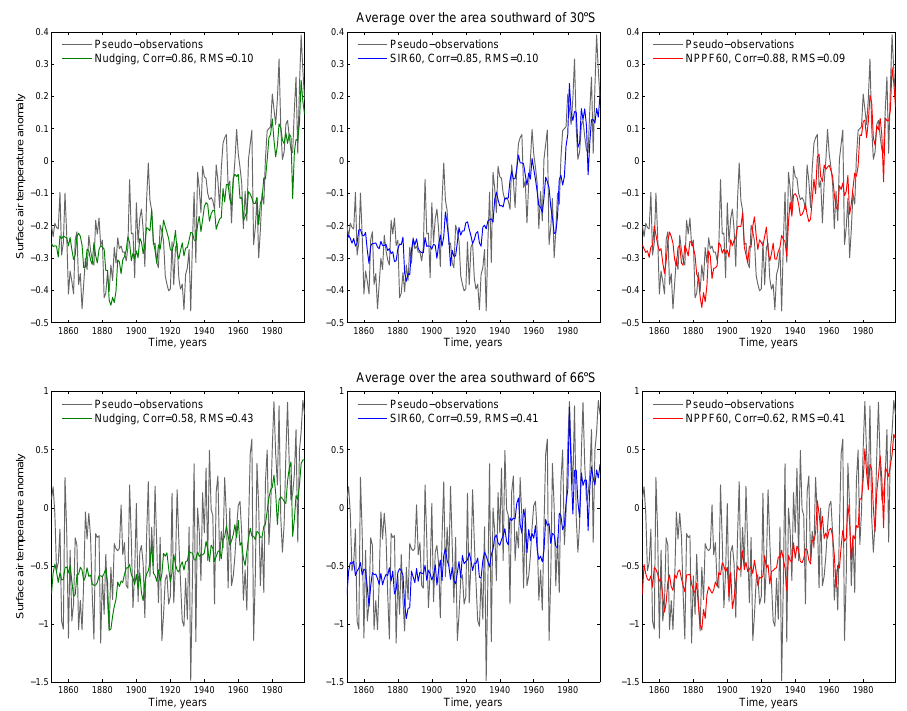
Fig. 6. Reconstructions of surface air temperature anomalies ( ◦ C) averaged over the area southward of 30 ◦ S (top panel) and over the area southward of 66 ◦ S (bottom panel), when the sparse pseudo-observations are assimilated. Gray line: pseudo-observations; green line: the nudging; blue line: the sequential importance resampling applied over the polar cap southward of 60 ◦ S; red line: the nudging proposal particle filter applied over the polar cap southward of 60 ◦ S. Correlations and the RMS errors are displayed in upper left corners.